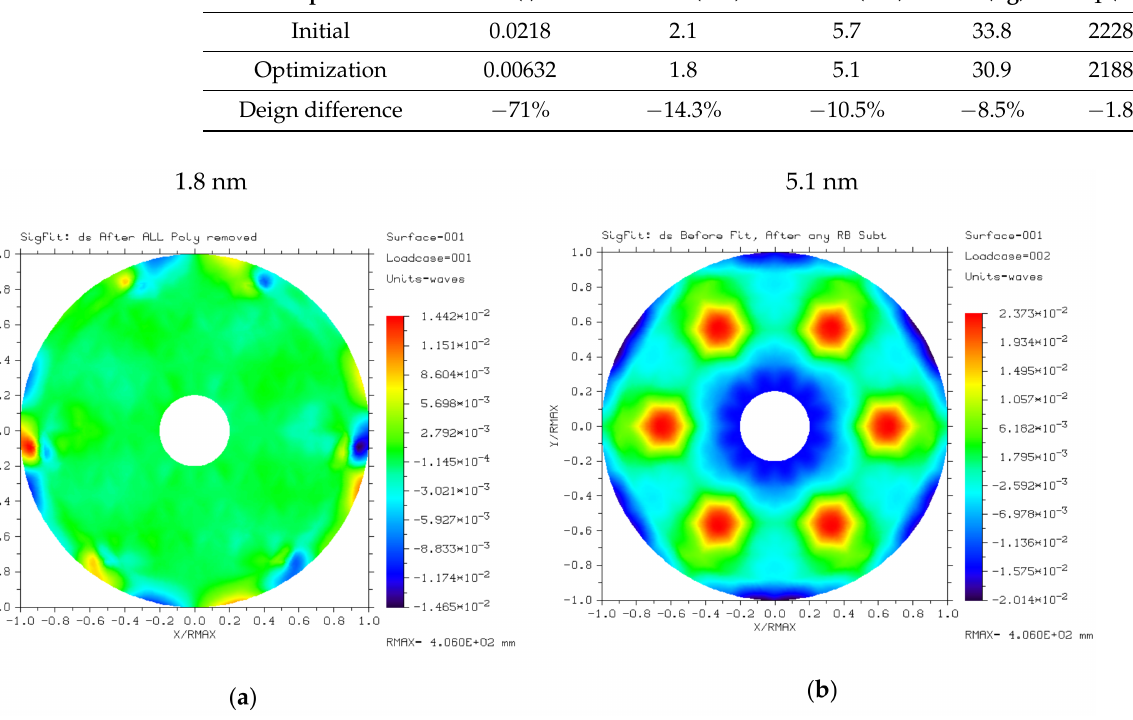
Figure 9. Result of mirror surface accuracy after optimization: ( a ) gravity vertical to the optical axis (RMSx) and ( b ) gravity parallel to the optical axis